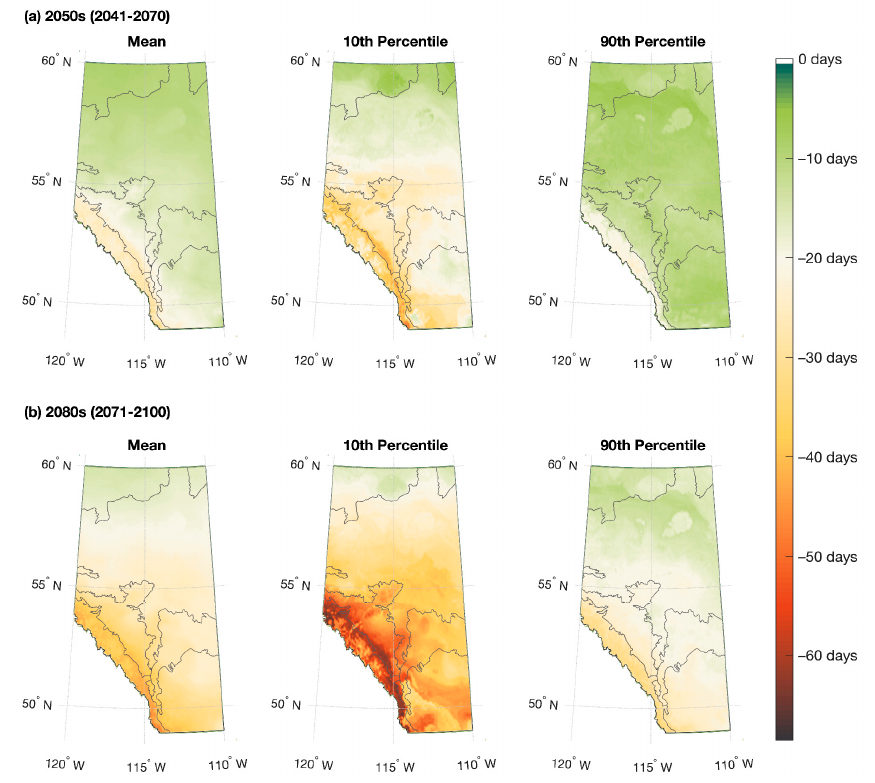
Figure 5. Projected change in spring 0 °C isotherm dates—mean, 10th percentile (earliest), and 90th percentile (latest) between the historic period (1950–2017) and ( a ) 2050s (2041–2070) and ( b ) 2080s (2071–2100) for RCP 8.5. Table 3. Average change in spring 0 °C isotherm timing, given in as the change in the number of days between the historic baseline and future periods.